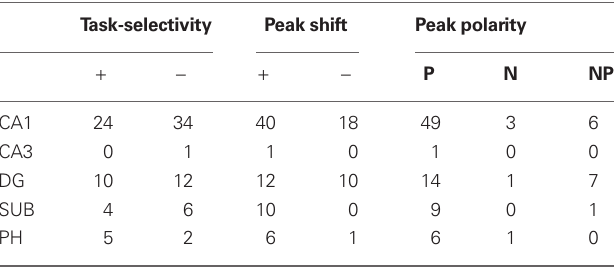
P vs. P, Pyramidal vs. pyramidal neurons. P vs. I, Pyramidal neuron vs. interneuron. I vs. I, Interneuron vs. interneuron. DG, dentate gyrus; SUB, subiculum; PH, parahippocampal gyrus. + , significant CCR; − , non-significant CCR. Table 2 | Characteristics of the neuron pairs with significant CCrs in each subregion of the HF and PH regarding task-selectivity, peak shift, and peak